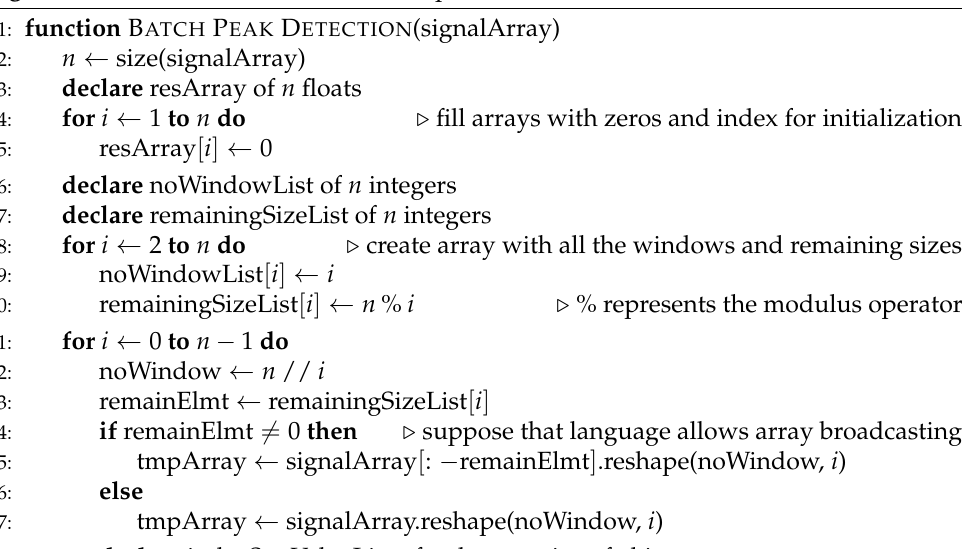
Figure 4. Visual explanation of cluster frontier extraction—phase 2: batch peak detection. Algorithm 2 Cluster frontier extraction—phase 2: Batch Peak